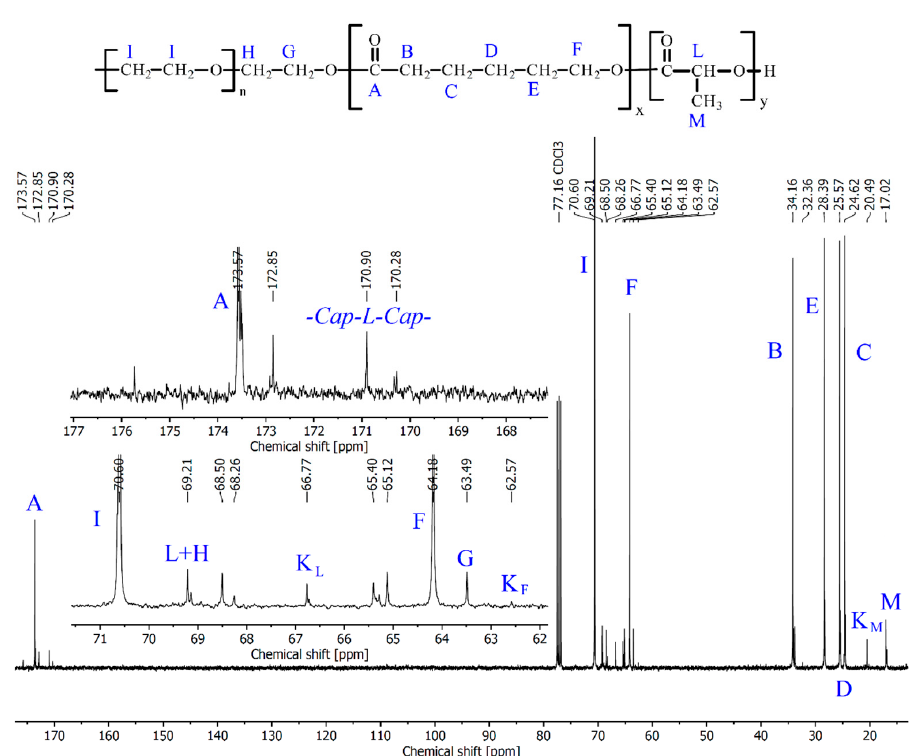
Int. J. Mol. Sci. 2023 , 24 , x FOR PEER REVIEW 6 of 33 Figure 2. 1 H NMR spectrum of the PCLA copolymer. Figure 2. 1 H NMR spectrum of the PCLA copolymer.